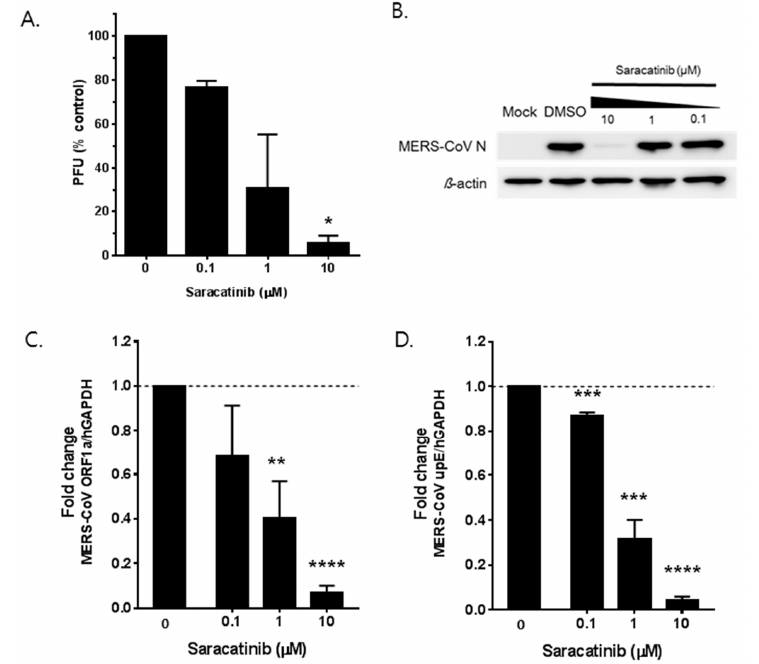
Figure 2. In vitro antiviral activity of saracatinib against MERS-CoV. Antiviral efficacy of saracatinib against MERS-CoV in Huh-7 cells. MERS-CoV infected Huh-7 cells were treated with saracatinib at indicated concentrations for 24 h, after which culture supernatant and cell lysates were